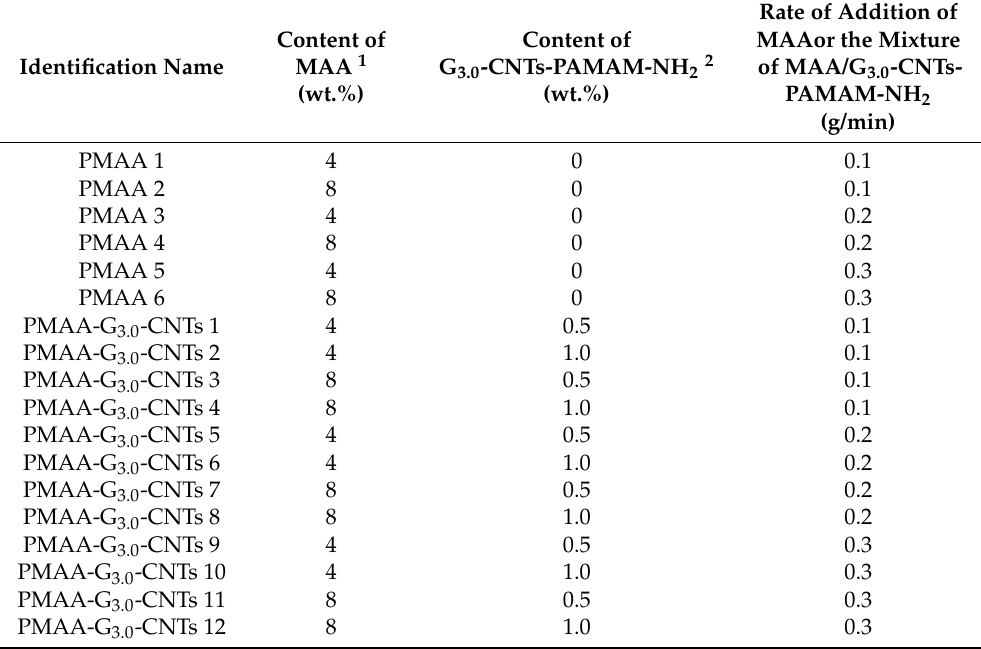
Table 1. Legends that identify the synthesized PMAA and their nanocomposites as a function of the formulation used and the rate of monomer feed. The content of G 3.0 -CNTs-PAMAM-NH 2 was calculated with respect to the mass of the MAA